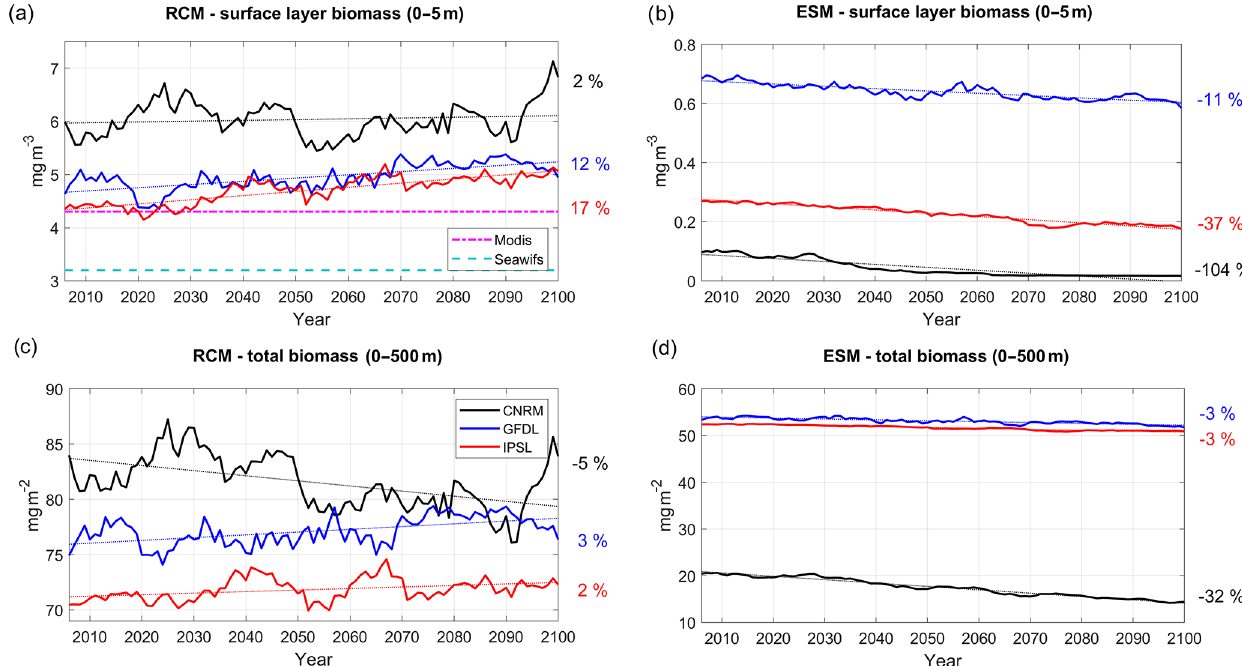
Figure 12. Surface chlorophyll (0–5m, mgChlm − 3 ) from (a) RCMs and (b) ESMs; depth-averaged chlorophyll concentration (0–50m, mgChlm − 2 ) from (c) RCMs and (d) ESMs. Color code: CNRM in black, GFDL in blue, IPSL in red. The time series are filtered using a 10-year moving average. Thin dotted colored lines indicate the linear trends. All variables are averaged in a coastal box (see Fig. 2a). Dashed cyan and dashed–dotted magenta lines in (a) mark the mean surface chlorophyll from SeaWiFS (1997–2010) and MODIS (2002–2015),